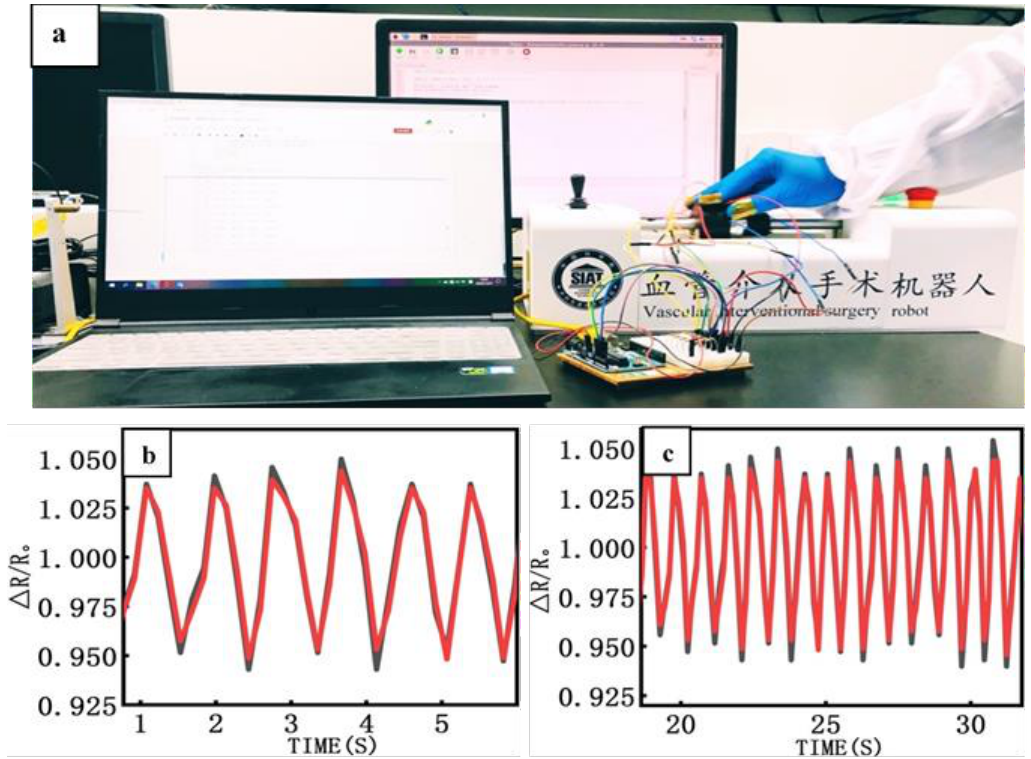
Figure 6. Application of the piezoresistive tactile sensor on intravascular intervention robot; ( a ) positioning of two tactile sensors on index and thumb fingers; ( b , c ) relative resistance change during push and rotate operations, respectively.